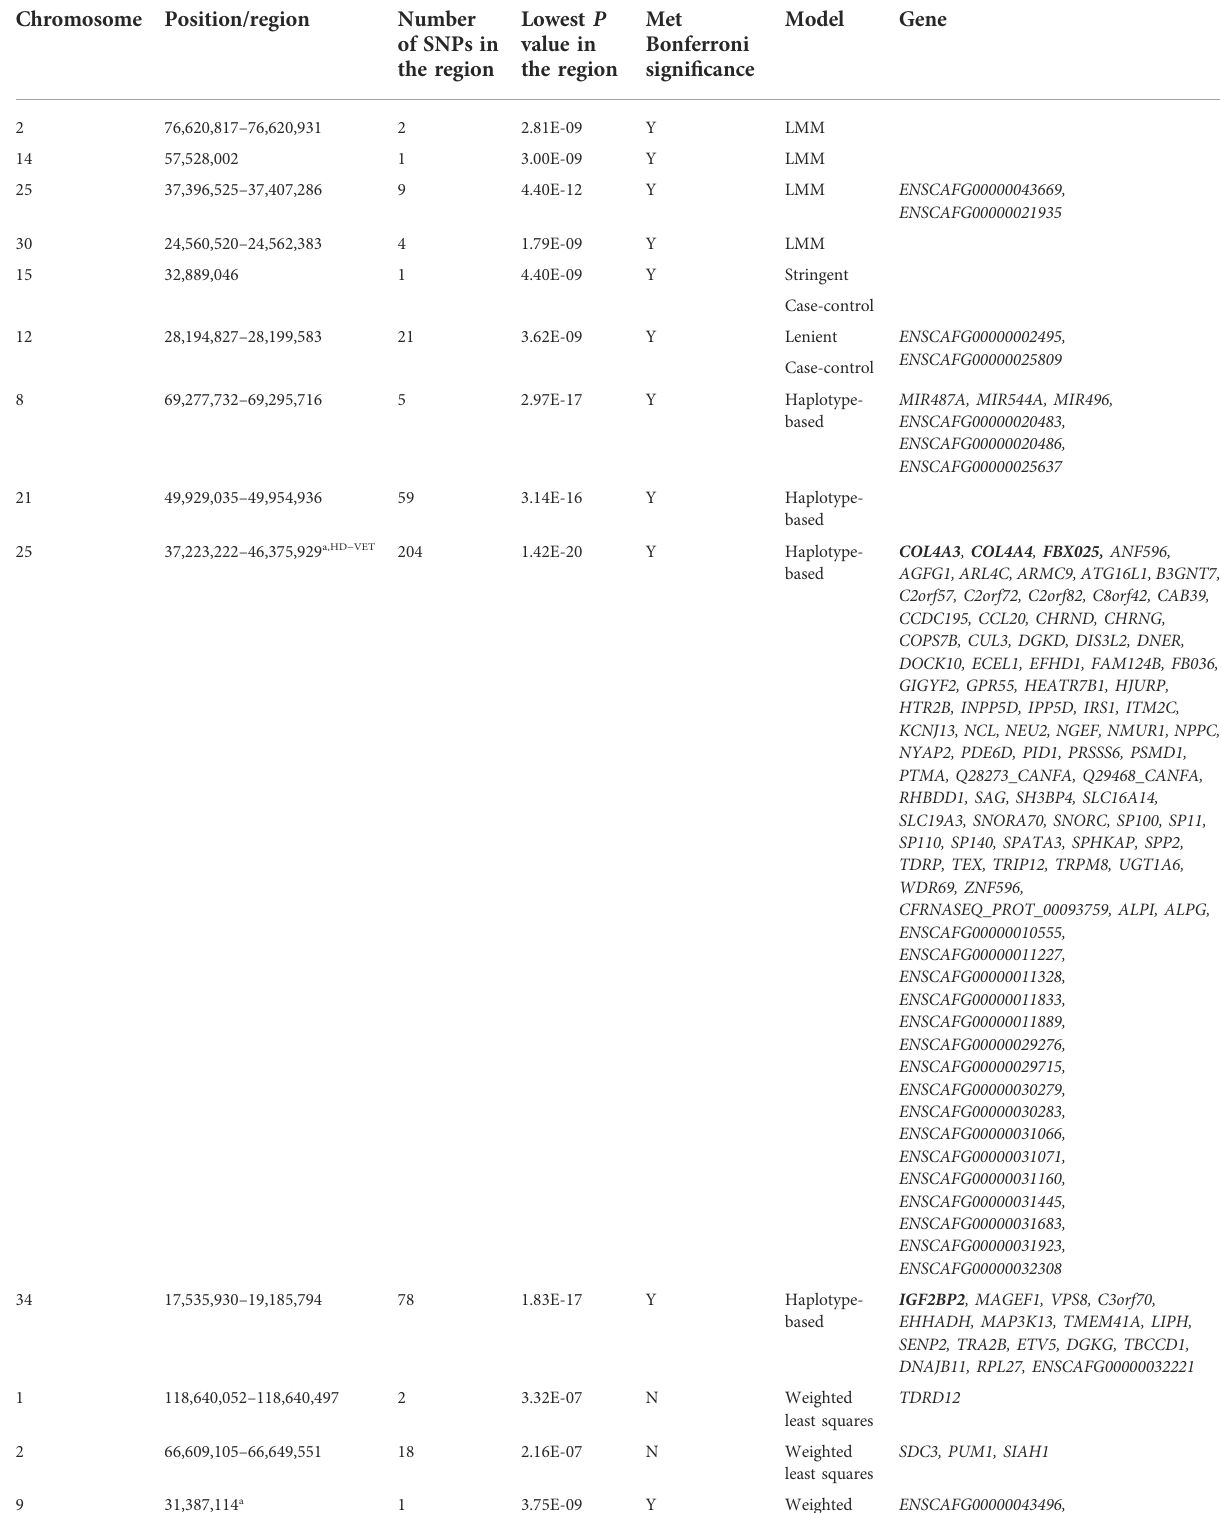
TABLE 3 Top candidate loci associated with OFA hip dysplasia in across-breed GWAS using breed phenotypes and four different association models. Chromosome Position/region Number